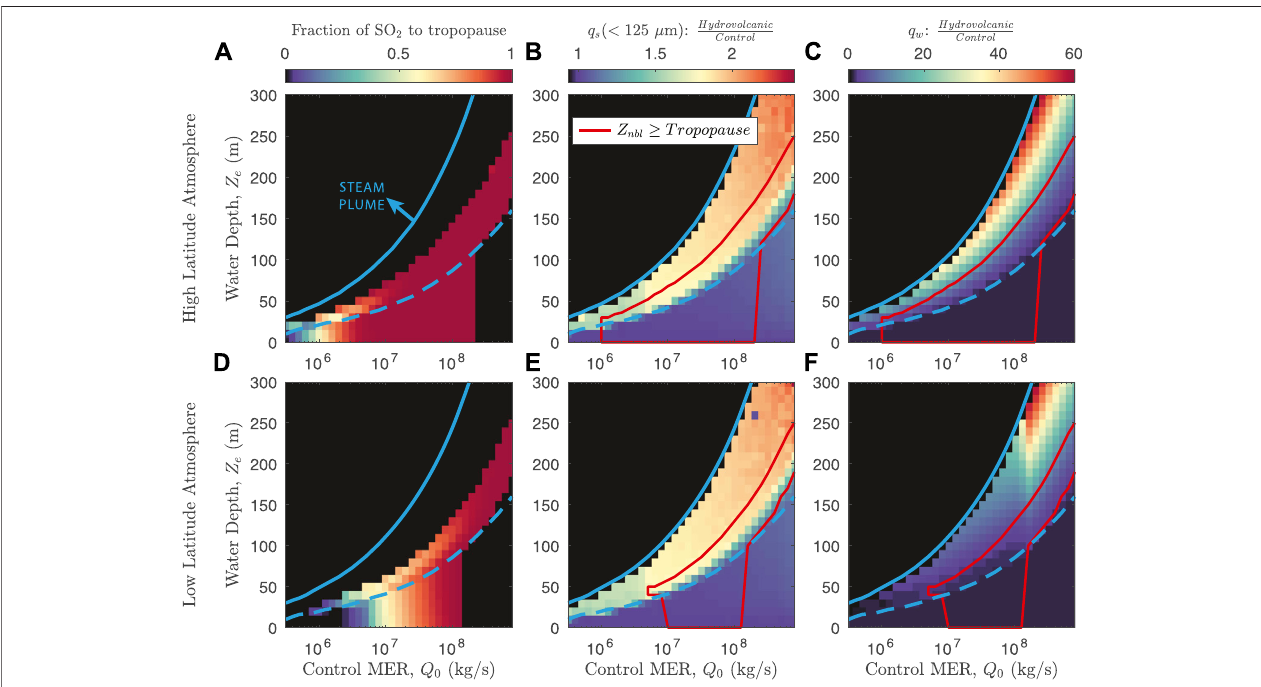
FIGURE 14 | Estimated fraction of SO 2 , fi ne ash mass fl ux, and water mass fl ux to the stratosphere. (A) Estimated fraction of outgassed SO 2 injected above the tropopause assuming a Gaussian injection pro fi le centered about the height of neutral buoyancy ( Equ. 66 ), as a function of control MER Q 0 and water depth Z e . In all panels, the dashed blue line is threshold water depth for water entrainment (decompression length equal to water depth, L d = Z e ), and the solid blue line is the threshold depth for steam plumes (see Figure 9 ). Black regions indicate column collapse. (B) Fine ash mass fl ux to the eruption column maximum height as a ratio of hydrovolcanic( Z e > 0)tocontrol( Z e =0)simulations,forparticlediameterslessthan125 μ m.Redlineoutlinessimulationswithbuoyantplumesatspreadingheightsator above the tropopause. (C) Water mass fl ux to the eruption column maximum height as a ratio of hydrovolcanic ( Z e > 0) to control ( Z e = 0) simulations. Black regions indicate the steam plume regime in panels (B,C,E,F) . Panels (A – C) are for with a high latitude (Iceland) atmospheric pro fi le ( Reference scenario). Panels (D – F) are the same as (A – C) , respectively, but for the low latitude (Equador) atmosphere ( Low-lat